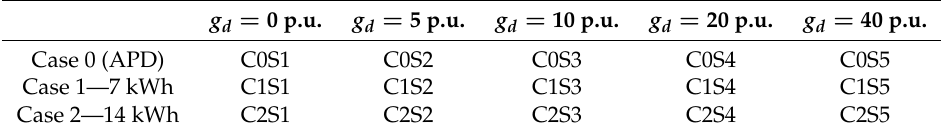
Table 4. Examined test